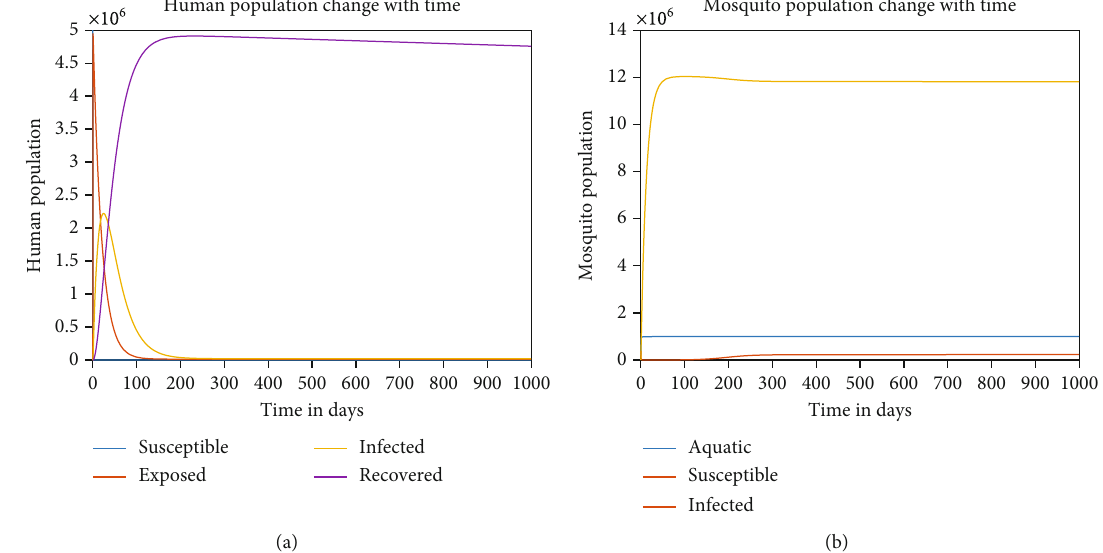
Figure 3: (a) Change in the human population with time over a period of 1000 days. (b) Change in mosquito population with time over a period of 1000